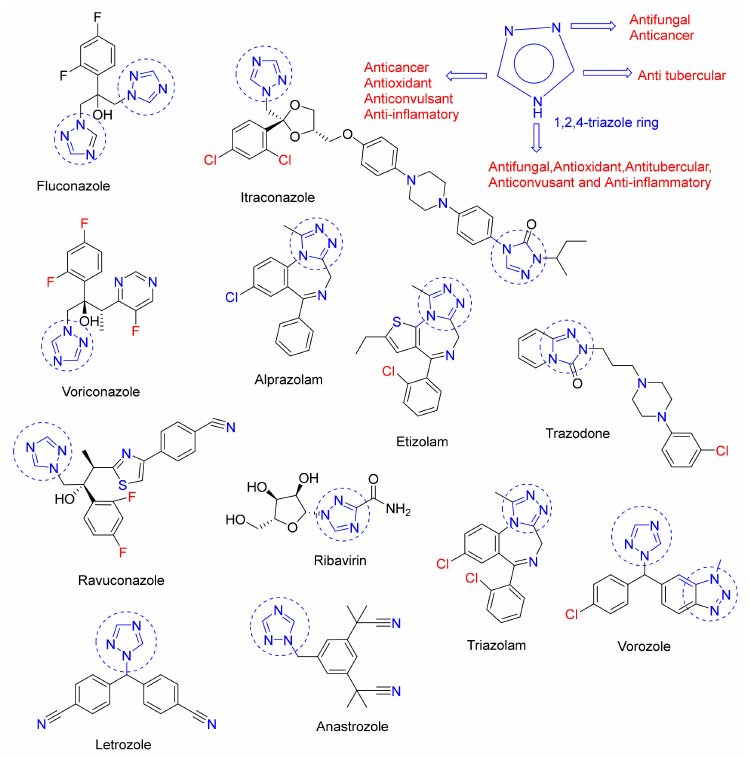
Figure 1. Drugs containing a 1,2,4-triazole ring are available in their therapeutic